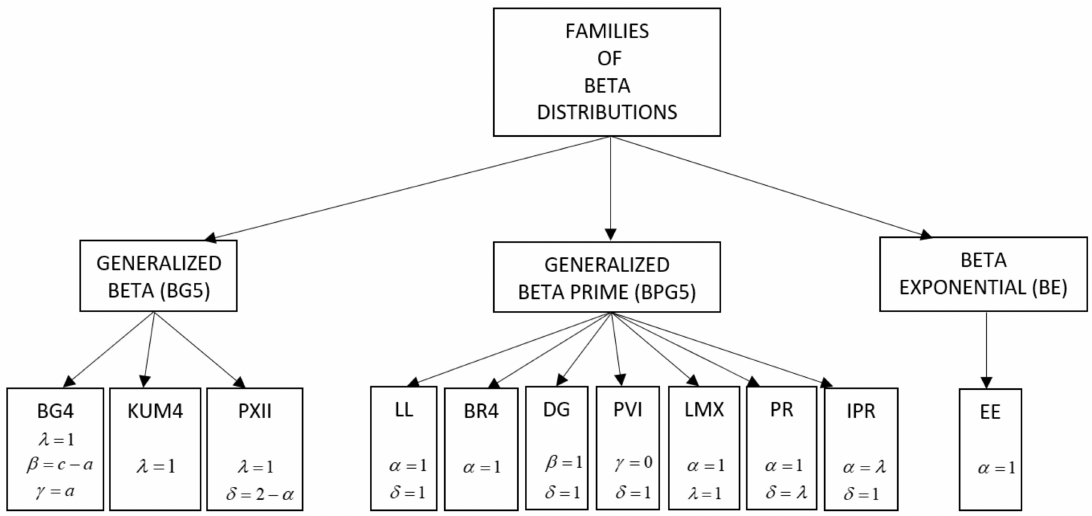
Figure 1. The relationships of Beta distribution families with other distributions. The determination of the maximum flows was carried out in stages according to Figure 2. The verification of the character of outliers, normality and homogeneity were carried out in the data curation phase.